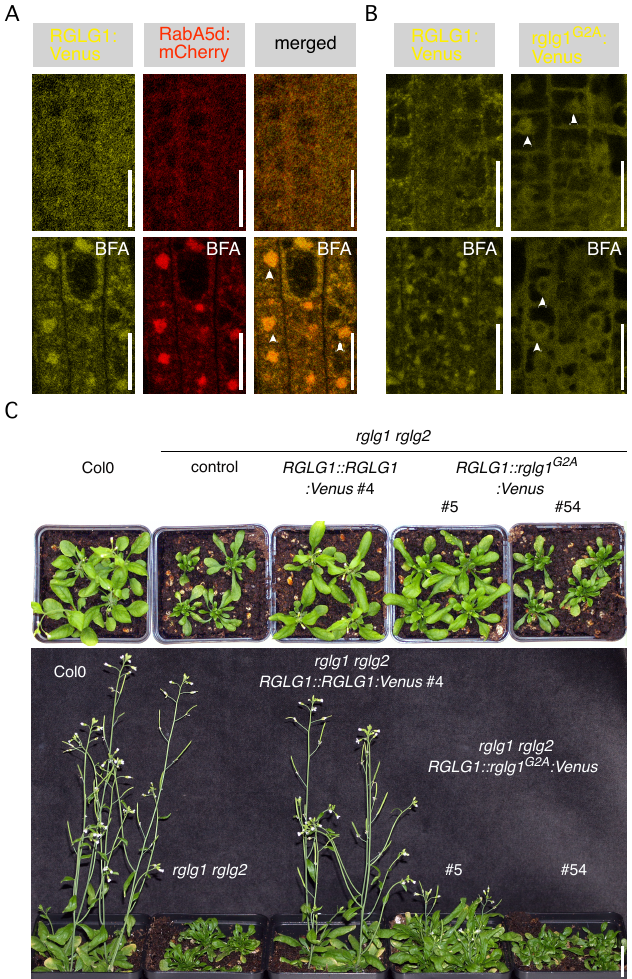
Figure 3. ( A ) RGLG1:Venus (yellow) and SYP32:mCherry (red) in root meristem mock-treated (top panels) or treated with BFA (50 µ M for 90 min; bottom panels). Accumulation in BFA compartments: arrowheads. Size bars: 10 µ m. ( B ) RGLG1:Venus (left panels) and rglg1 G2A :VENUS (right panels) in root meristem mock-treated (top panels) or treated with BFA (50 µ M for 90 min; bottom panels). Accu- mulation of rglg1 G2A :Venus in nucleus: arrowheads. Size bars: 10 µ m. ( C ) Top: Comparison of (from left to right) Col0, rglg1 rglg2 , rglg1 rglg2 RGLG1::RGLG1:Venus #4 , rglg1 rglg2 RGLG1::rglg1 G2A :Venus #5 and #54 at the stage of bolting (24 days after germination). Bottom: Comparison of (from left to right) Col0, rglg1 rglg2 , rglg1 rglg2 RGLG1::RGLG1:Venus #4 , rglg1 rglg2 RGLG1::rglg1 G2A :Venus #5 and #54 at 32 days after germination. Size bar: 2